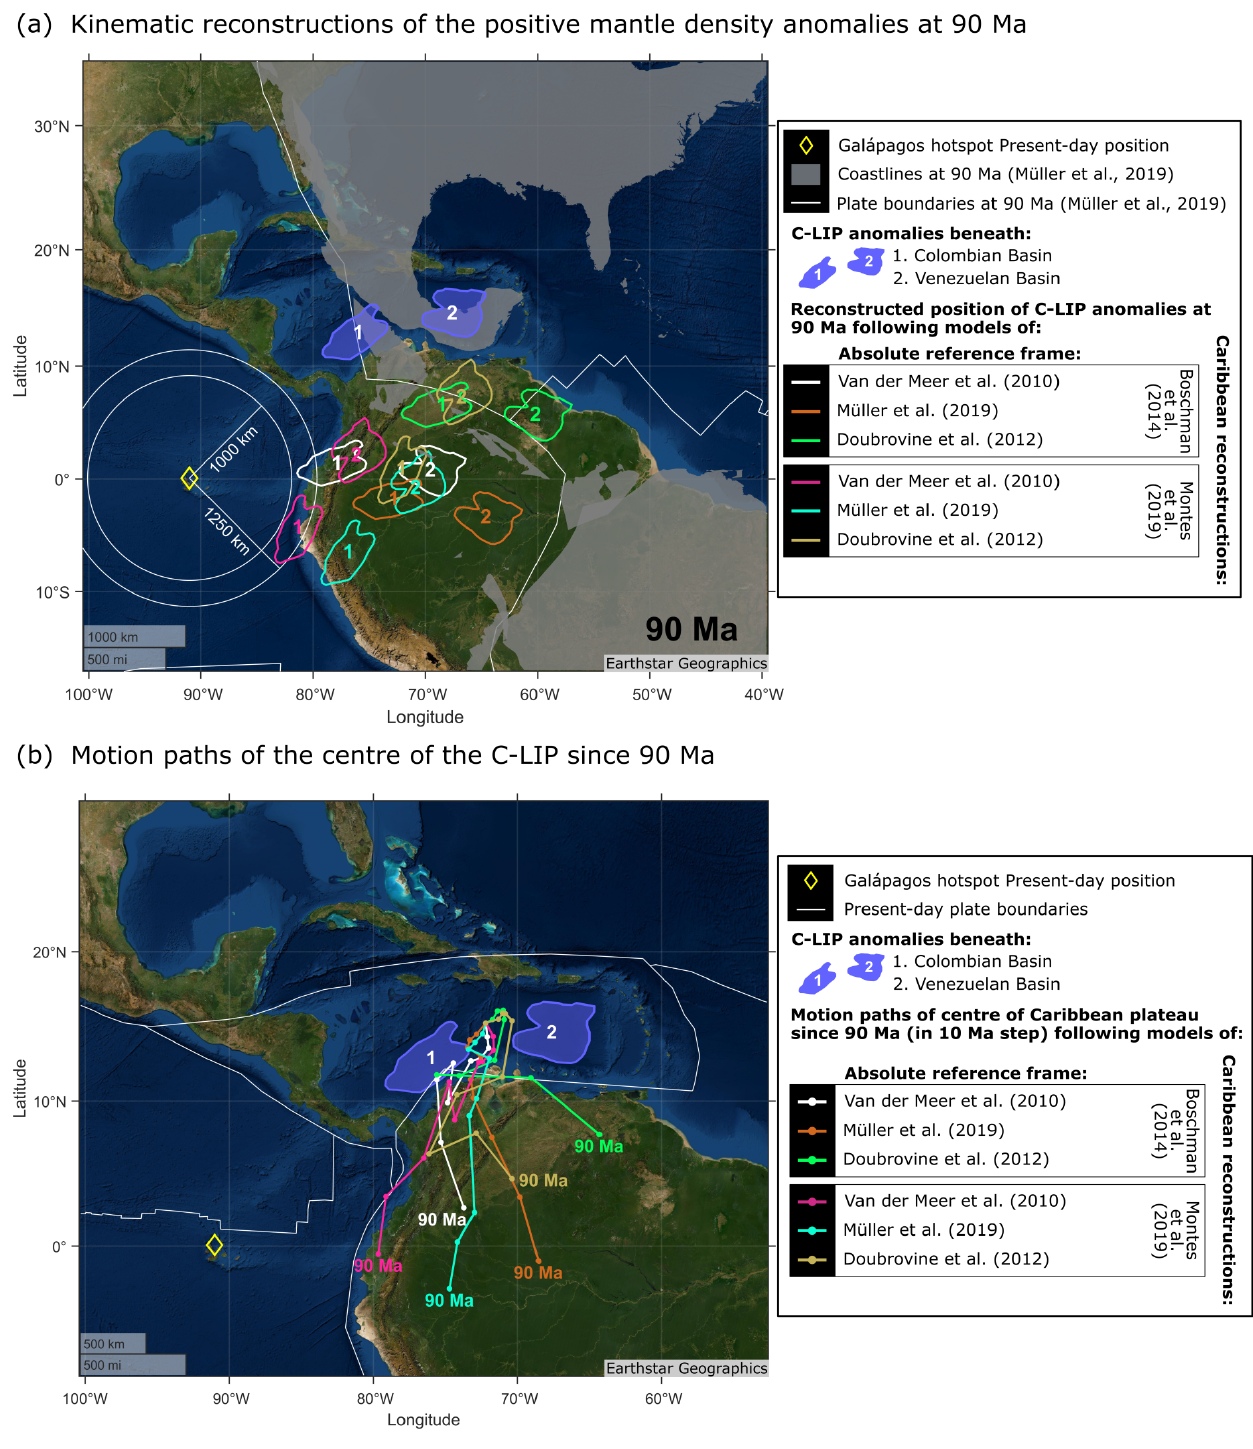
Figure 13. Kinematic reconstructions using three different absolute reference frames and two regional Caribbean reconstructions show an offset between the positive mantle density anomalies and the location of the Galápagos hotspot back to 90Ma. (a) Reconstructions at 90Ma using the plume conduits polygons beneath the Colombian and the Venezuelan basins (numbers 1 and 2, respectively). White circles represent the plausible head of the Galápagos plume assuming a 2000 and 2500km diameter above a fixed plume. Present-day topography in the background for reference. (b) Motion paths of the centre of the C-LIP since 90Ma (in 10Ma steps). Different coloured lines depict the six different tested